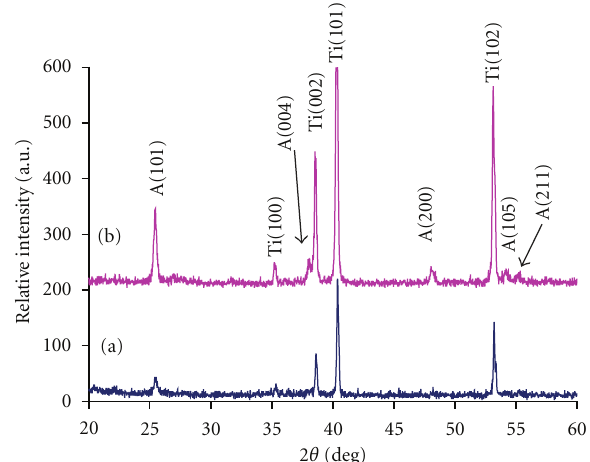
Figure 4: XRD patterns of (a) TNT and (b) TNT/EDTA calcined at 500 ◦ C. A and Ti represent anatase and titanium, respectively.